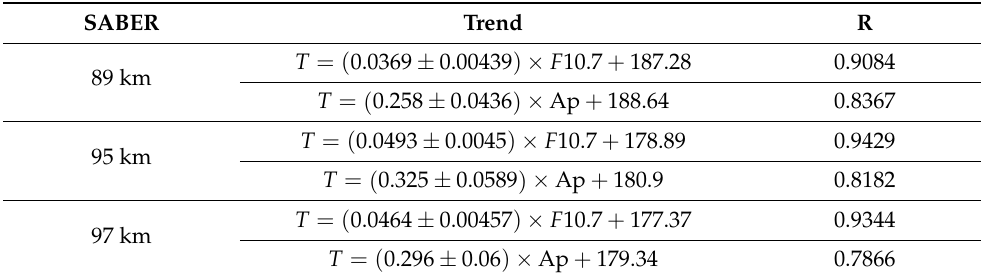
Figure 7. Annual average of zonal mean SABER temperature at 18° N at 95 km with the Ap index shifted 1 year backward. ( a ) Time series of temperature (blue line with dots), F10.7 (red line), and Ap index (brown dashed line). ( b ) Trend analysis of temperature as a function of the F10.7 (red line and dots) and of the Ap index (brown dashed line and triangles). Table 3. F10.7 and Ap index trends with correlation coefficient R obtained from the zonal mean SABER temperature measurements fitted with 1-year shift in the Ap